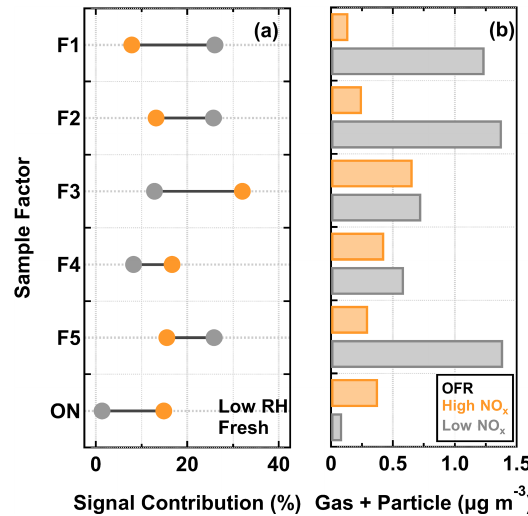
Figure 6. Signal contributions of sample factors to their total sum (a) and the corresponding estimated mass concentrations in the gas and particle phase (b) for α -pinene SOA particles that were formed under low NO x and high NO x conditions in the OFR and evap- orated under the low RH and fresh condition. Note that here ON indicates the sum of the ON sample factors. The fraction is calcu- lated by normalizing the measured sum from a PMF sample factor to the total sum of sample factors in the low RH and fresh samples under low NO x and high NO x